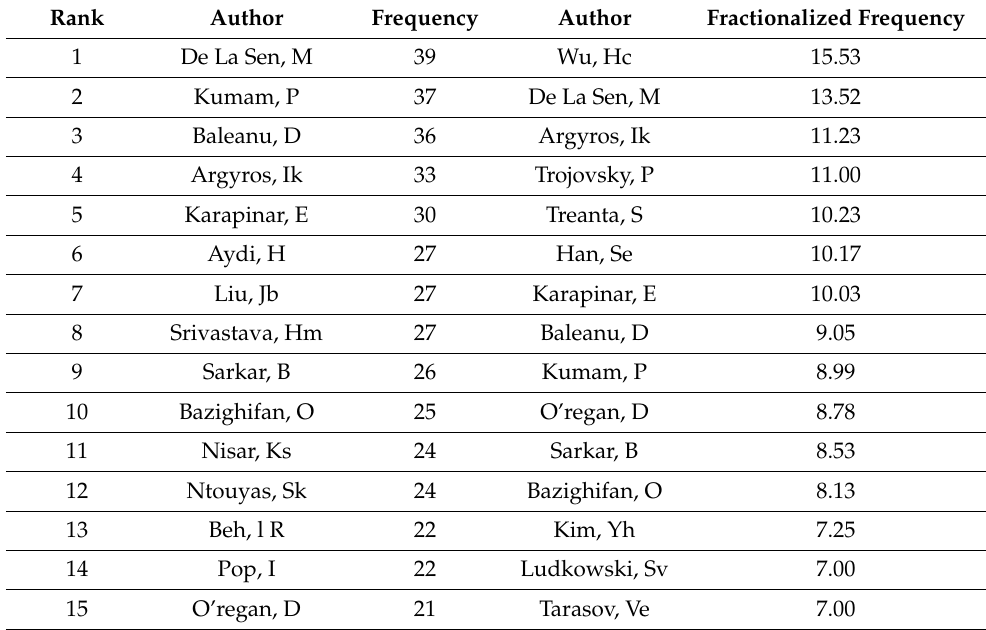
Table 2. Author productivity rankings by publication count and fractionalized frequency.